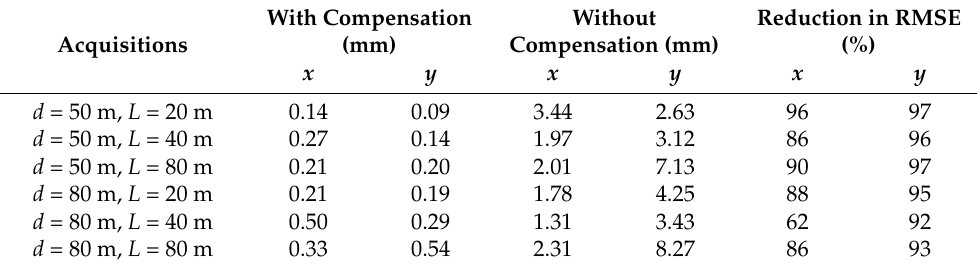
Table 1. RMSEs with/without camera motion